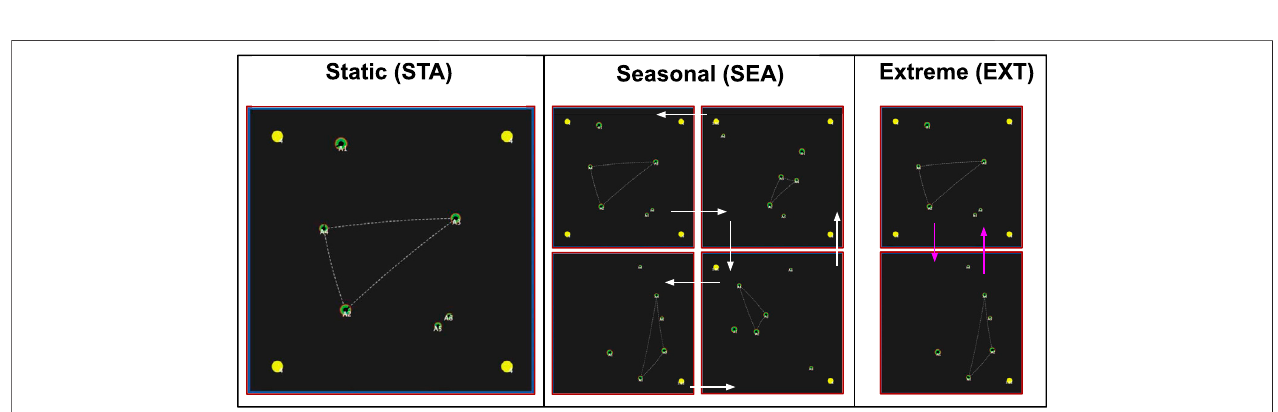
FIGURE 5 | Screenshots of the three environments that our experiments were conducted in. Yellow spheres = food resources. Green discs = agents. Left: The Static (STA) environment, with four fi xed food resources in each corner of the simulated environment. Centre: The Seasonal (STA) environment. After 2000 time steps, food resources (yellow spheres) incrementally decrease by one resource every 1,000 time steps (inner white arrows); and then increase at the same rate (outer white arrows). Right: The Extreme (EXT) environment. After 2000 time steps, food resources immediately change from four to one, back to four, every 1,000 time steps. The size of the disc represents an agent ’ s rank (the higher the rank, the larger the agent).